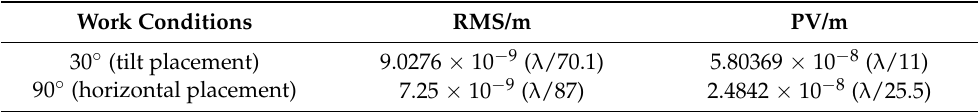
Table 6. The results of the main mirror surface shape in both working conditions.